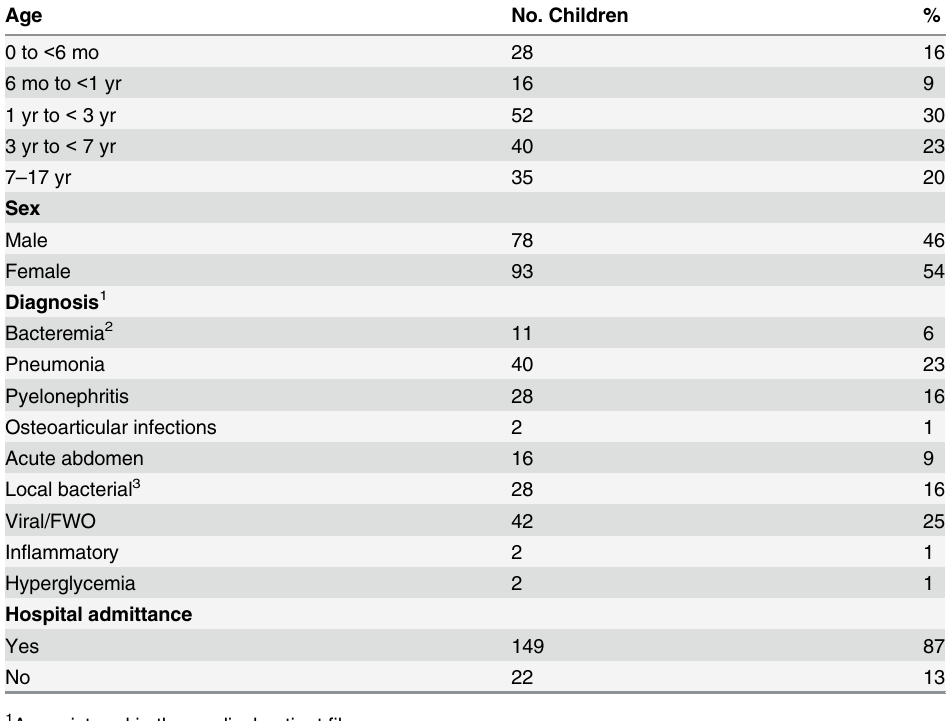
Table 1. Characteristics of 168 children included in the study at the pediatric emergency